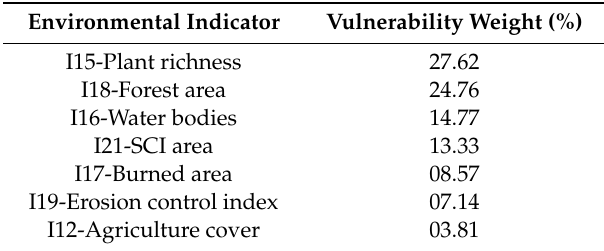
Table 3. Environmental indicators and vulnerability weights calculated for Ordesa and Monte Perdido National Park based on expert